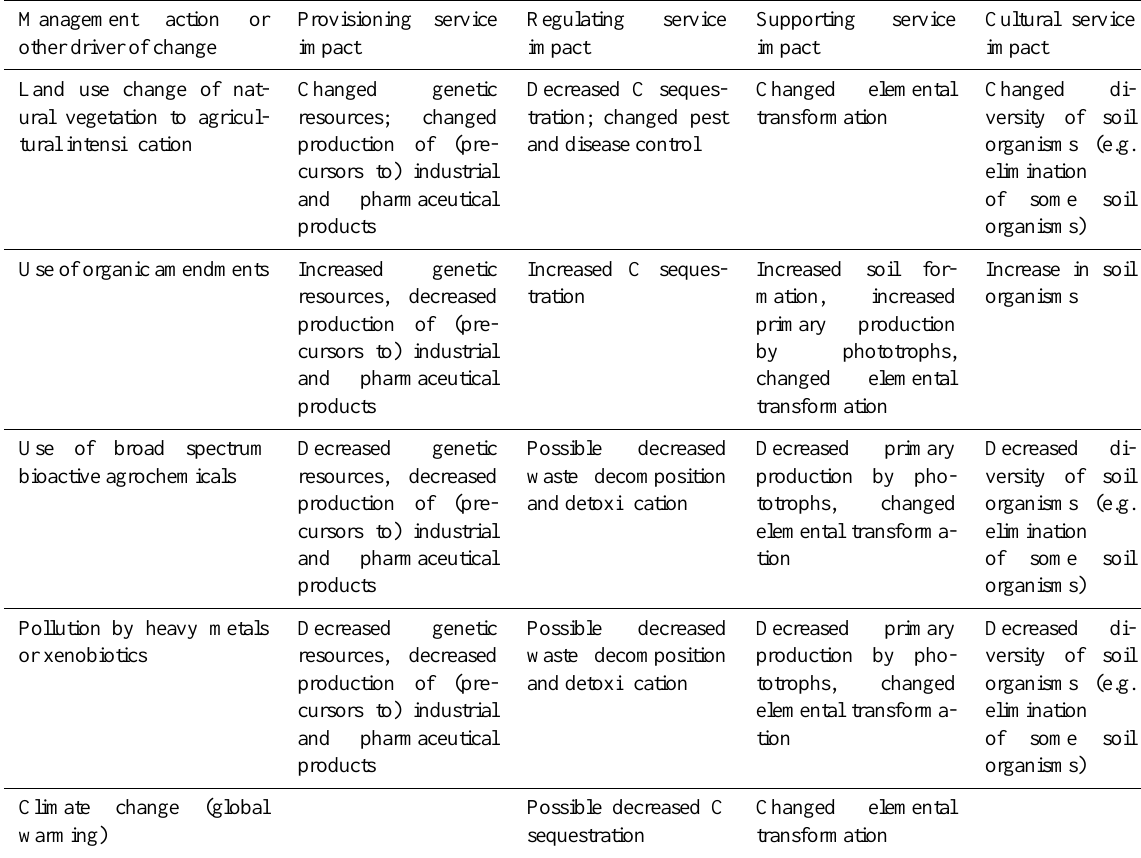
Table 5. Management actions affecting the soil biota and their impacts on ecosystem